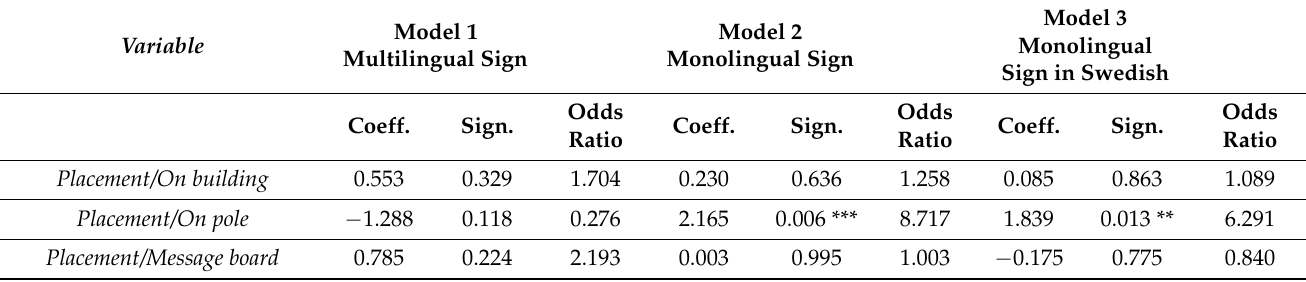
Table A1. Estimates of sign characteristics on the likelihood of language appearance on signs